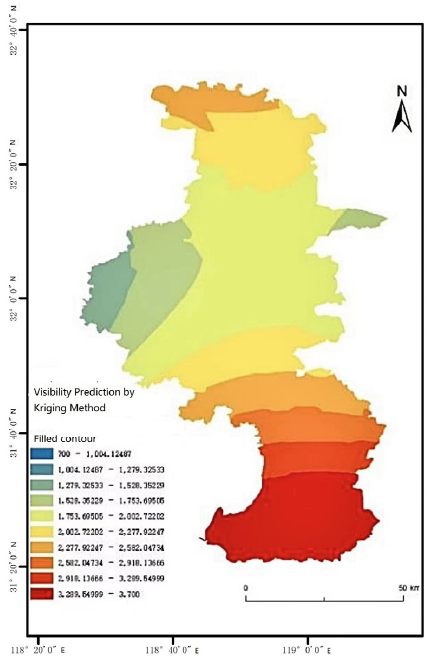
Figure 4. Visibility prediction by the Kriging interpolation method.